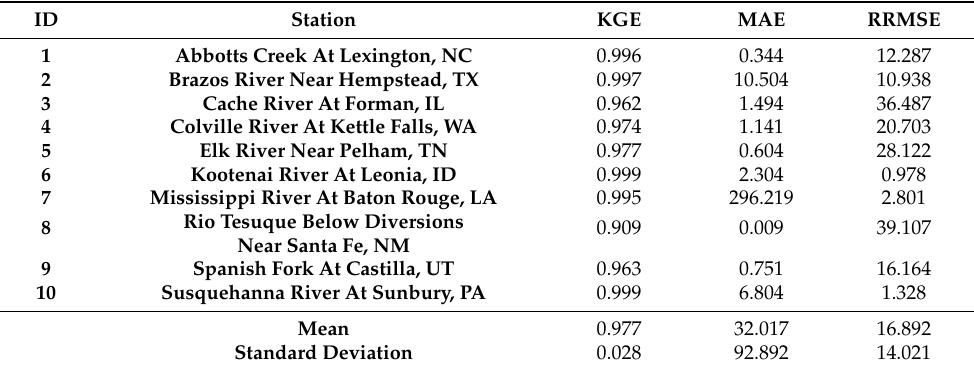
Table 7. Results of validating the Rating Curve for ten different stations in the US. The overall performance was comparable to Cambodia. ID Station